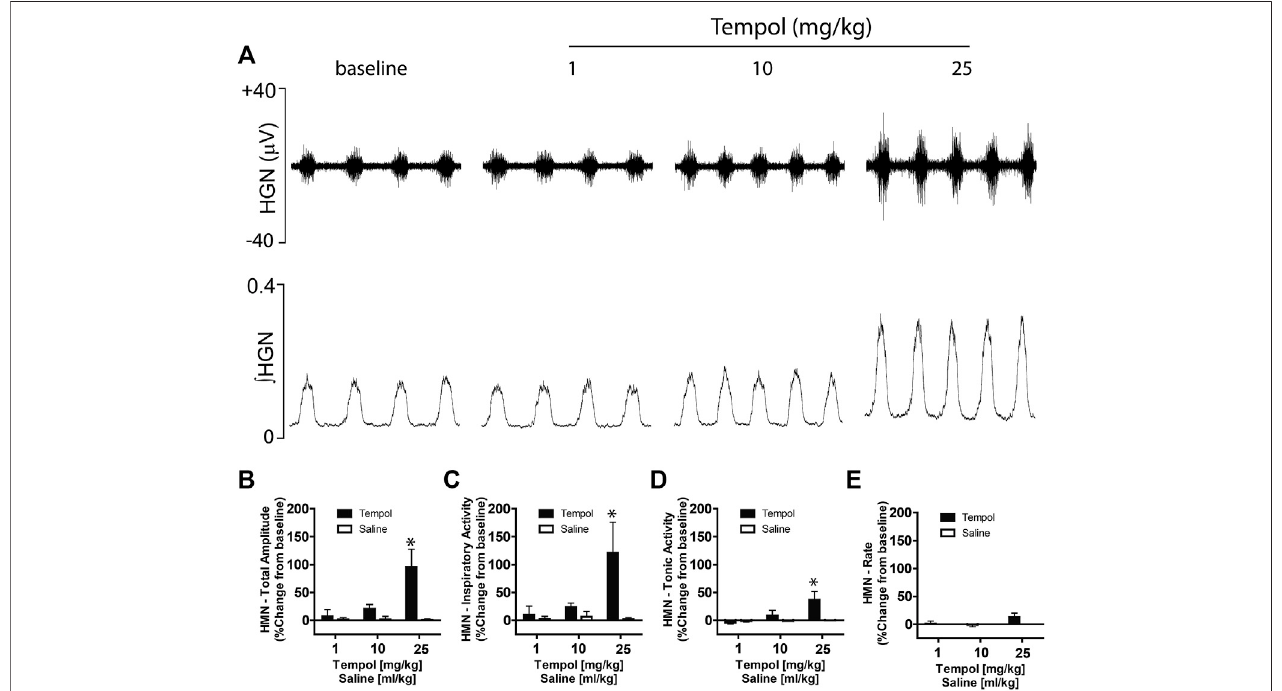
FIGURE7| Tempoldose-dependentlyincreasedhypoglossalmotoneuron(HMN)output.RepresentativerecordingshowingthatTempoleliciteddose-dependent (1, 10 and 25 mg/kg, IV) increases in HMN output in anesthetized, neuromuscularly paralyzed and mechanically-ventilated Sprague-Dawley rats (Panel A) . Summary data demonstrating that Tempol-induced dose-dependent increases in total amplitude (Panel B) , inspiratory activity (Panel C) and tonic activity (Panel D) without signi fi cant change in HMN burst frequency (Panel E) . Repeated administration of saline (time control) had no effects on HMN output (Panels B – E) . Values are presented as mean ± SEM. There were four rats in each group. * p < .05, signi fi cant change from baseline.